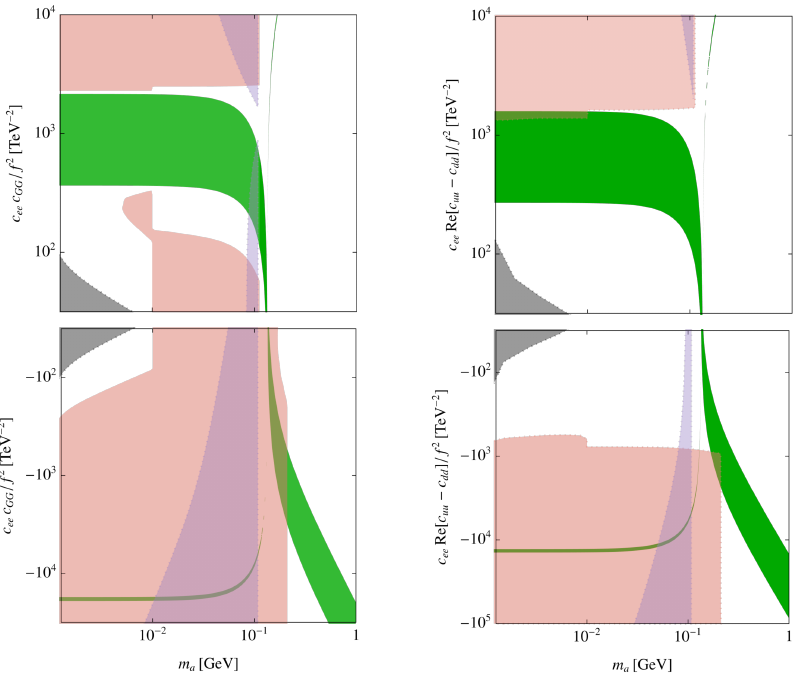
Figure 32 . Parameter space for which an ALP can explain the KTeV anomaly by ALP couplings to electrons and first generation quarks (left) or gluons (right) at 1 σ . Constraints from K + → π + e + e − decays are shown in red, K + → π + γγ in blue and K + → π + + invisible in dark gray. For